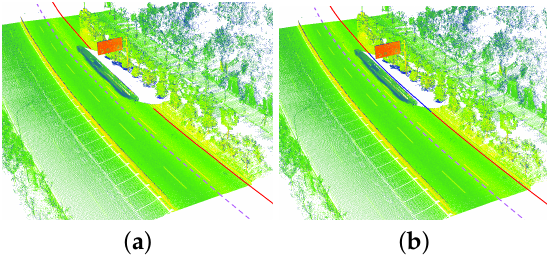
Figure 28. A case of global post-processing for complementing the missing lane line. ( a ) The map before global post-processing. The lane line in a road section is missed due to the occlusion of a vehicle. The dotted purple line is the trajectory, and the red lines are the correctly extracted lane lines before and after this road section. ( b ) The blue line is the complementary lane